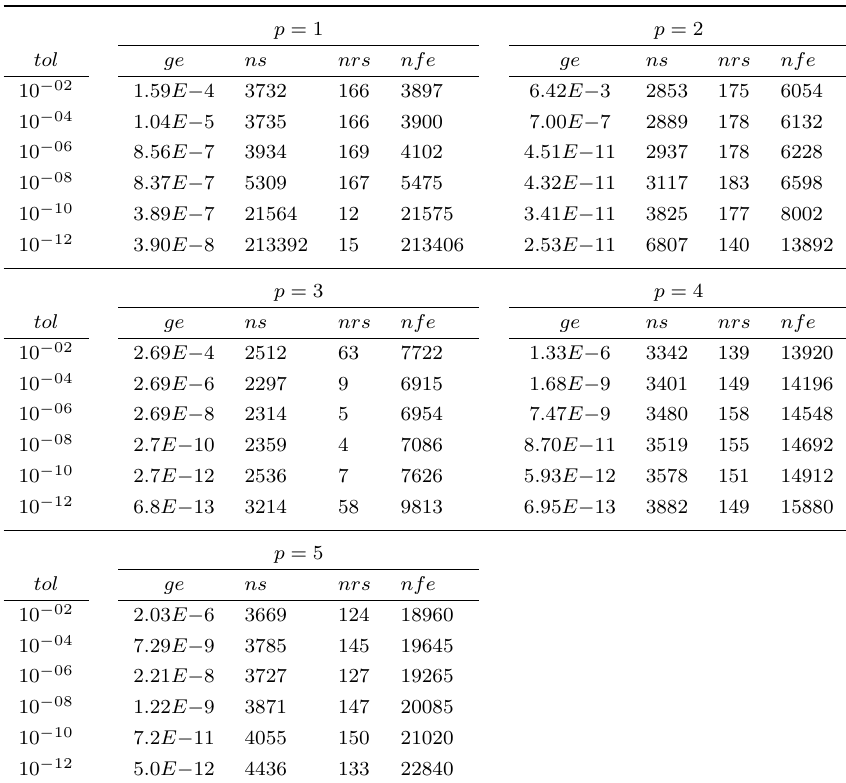
Table 6. Results of numerical experiments for van der Pohl equation (4.3) with PI controller, whose parameters are those defined in (3.3) p = 1 p = 2 tol